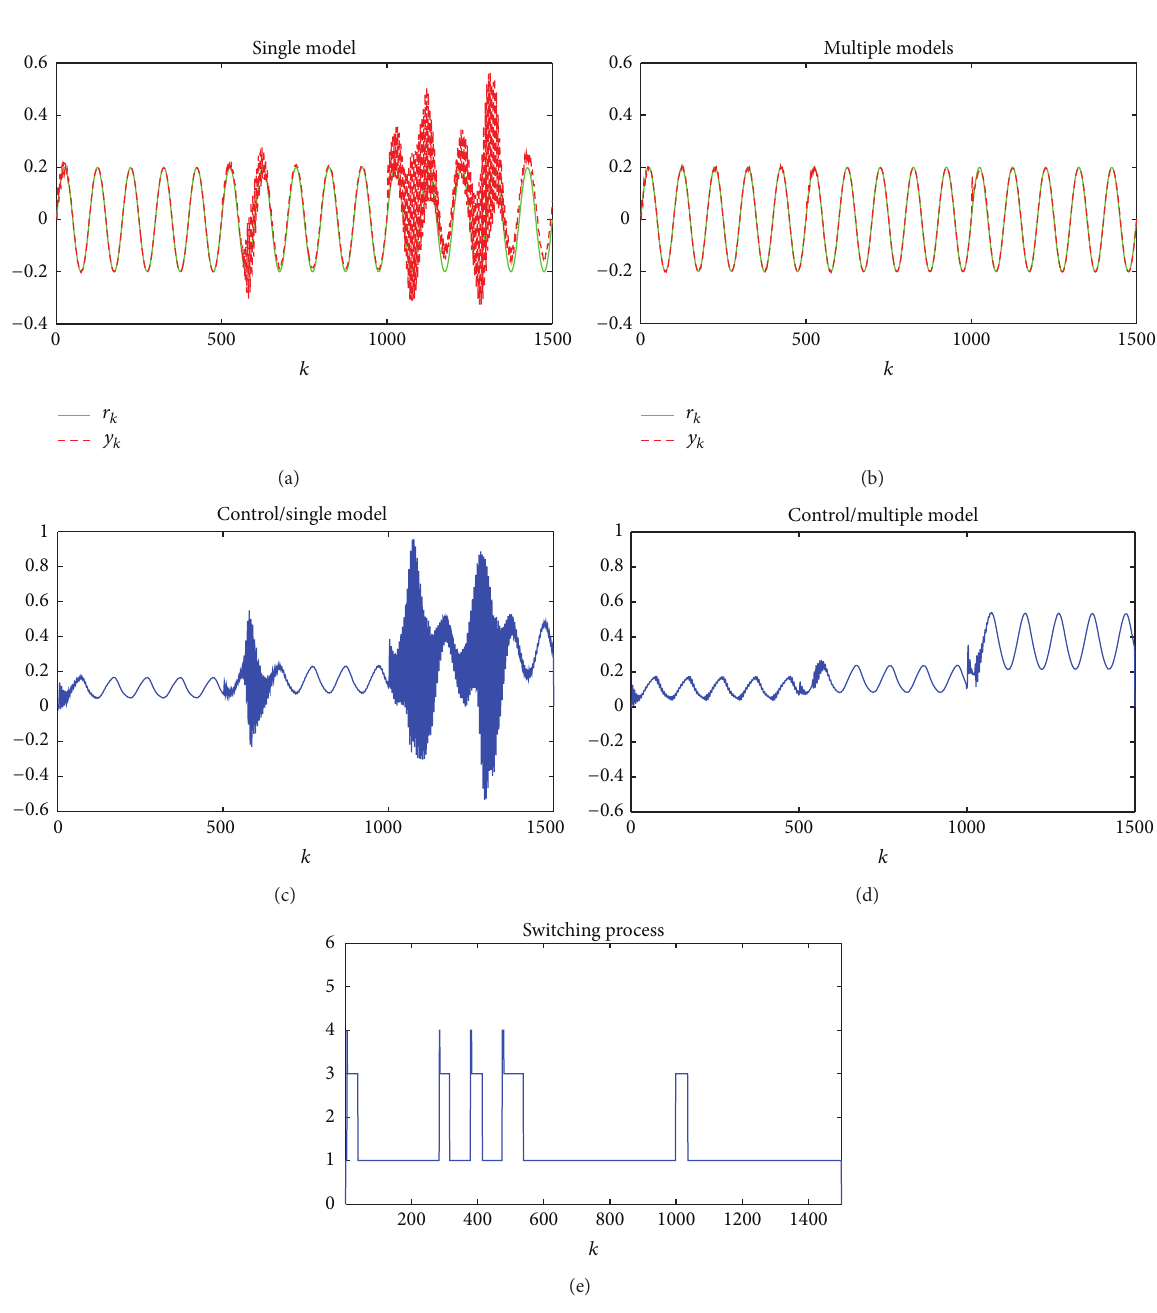
Figure 7: Multiple OS-ELM neural network models adaptive